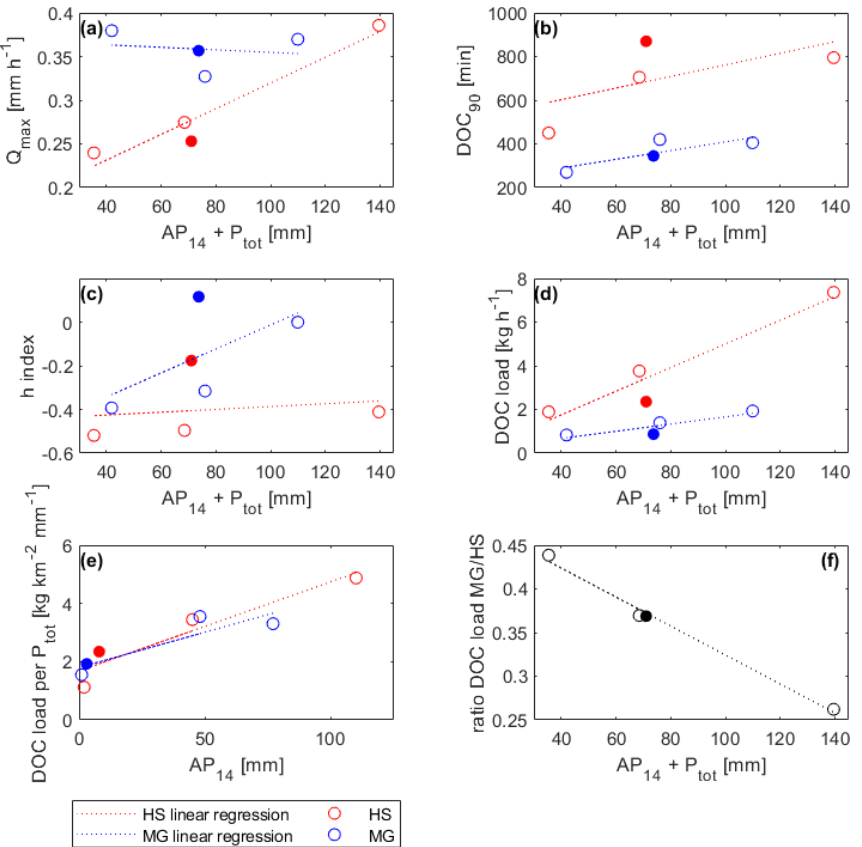
Figure 3. (a–d) Event parameters as a function of the sum of AP 14 and P tot (total catchment wetness) at the upper site (HS) and the lower site (MG). The closed symbols indicate the September 2020 event with its much larger amount of precipitation. (e) Precipitation-specific DOC load (kgkm − 2 mm − 1 ) as a function of AP 14 . (f) The ratio of the DOC load of MG / HS as a function of total catchment